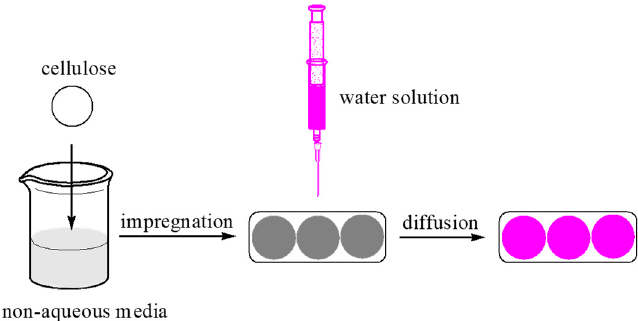
Figure 2. A schematic diagram of reactive dye solution diffusion in the siloxane non-aqueous dyeing